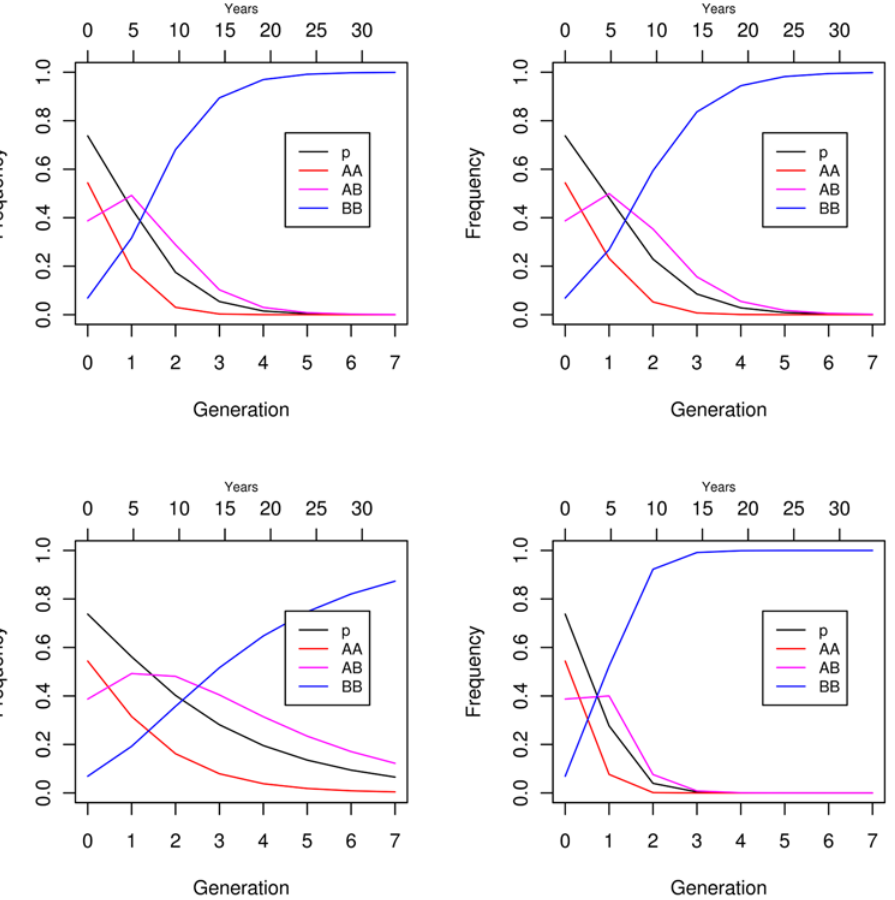
Figure 7. Predicted allele and genotypic frequency changes with a constant-fitness viability model of selection. Top left panel based on fitness estimates from Table 6; top right panel based on fitness estimates from Supplementary Table S2; lower left panel based on highest fitness estimates from Table 6 (a best case scenario); lower right panel based on lowest fitness estimates from Table 6 (a worst case scenario). Starting frequency of 0.738 assumed based on intercept of gam fit in Figure 6. Years based on a generation time of 4.8 years [36]. Color codes are black for the A allele and red, magenta, and blue for the AA , AB , and BB genotypes respectively.